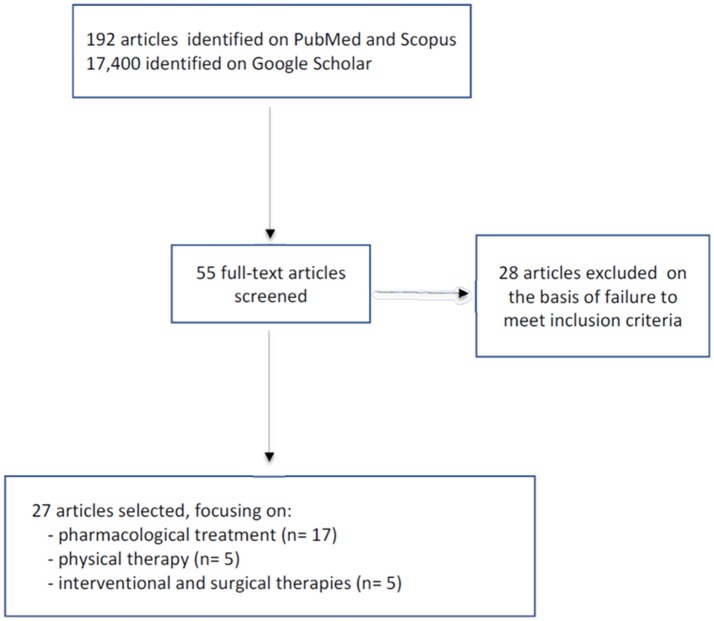
The search strategy.